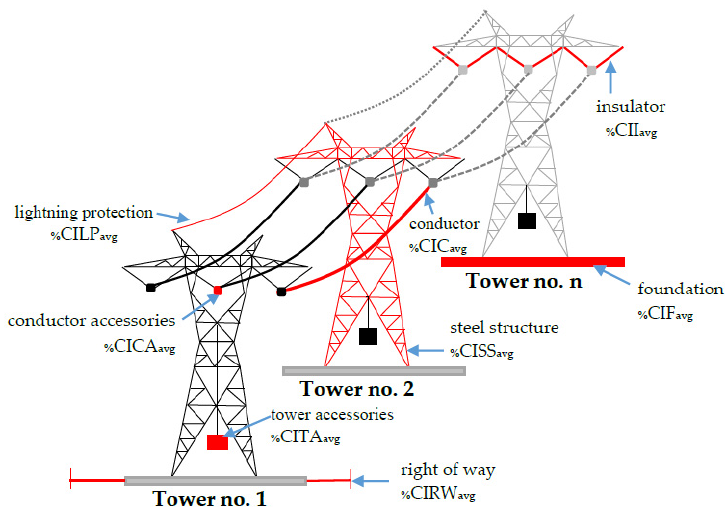
Figure 1. Overhead transmission line components for condition assessment . Table 1. Transmission line components.